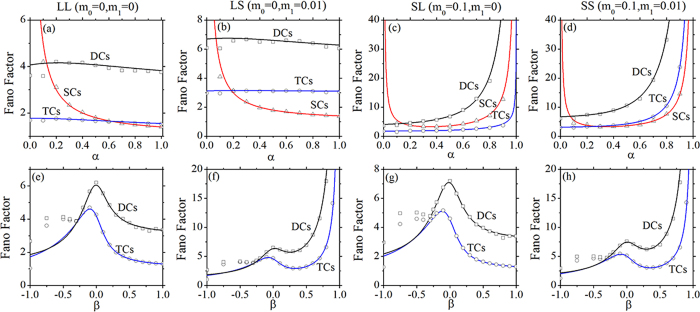
Fano factors as a function of α (upper row) and β (bottom row) obtained by Langevin method20 (lines) and Gillespie algorithm29 (symbols) with Ω = 200.(a–d) α2 = 0.4, β = 0.432. (e–h) α = 0.2, α2 = 0.3. All the parameters are measured in hr−1.